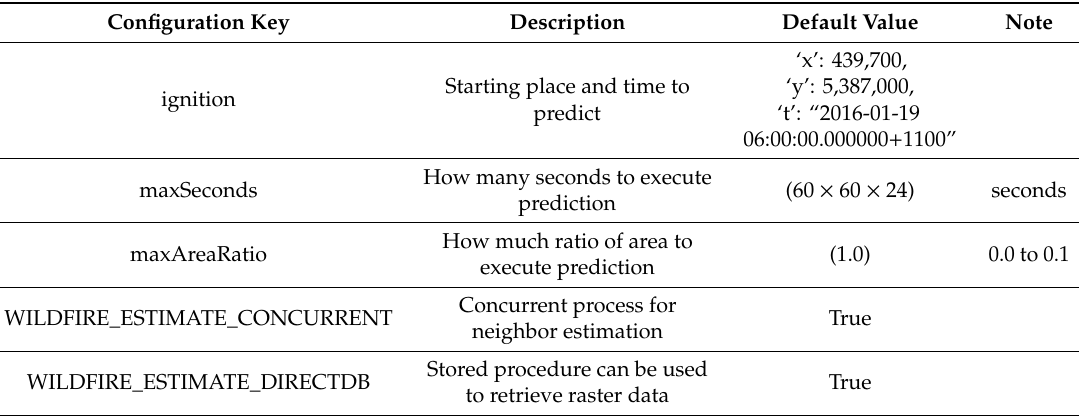
Table 8. Configuration for fire